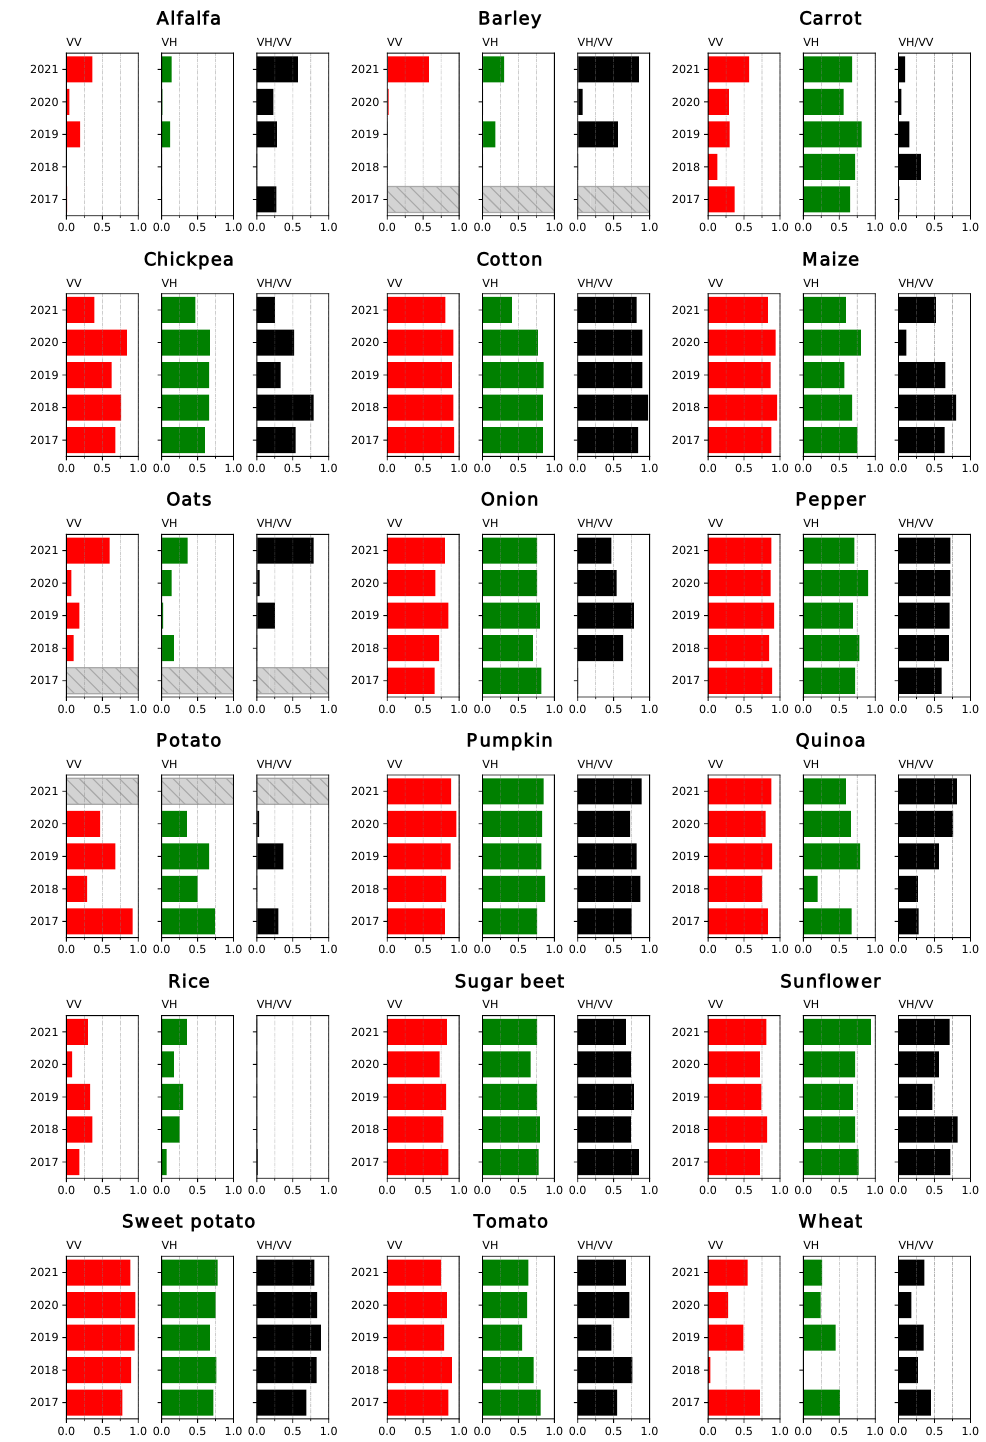
Figure 5. Coefficient of determination ( R 2 ) for the linear regressions between coherence and NDVI, restricting the series to the growing season. Years without data for a specific crop type are identified with a striped